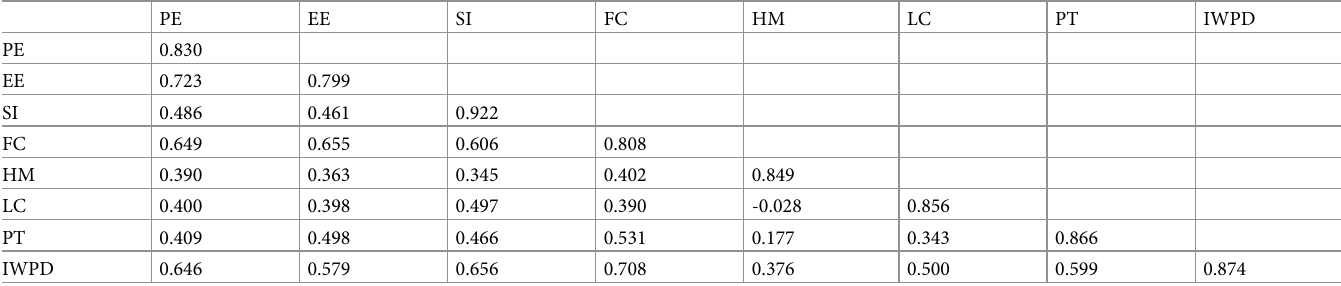
Table 5. Discriminant validity (Fornell-Larcker